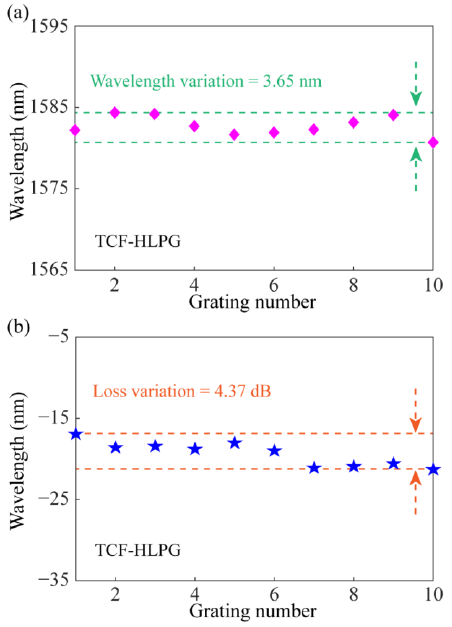
Figure 9. ( a ) The variation of resonance wavelength in the transmission spectra of different TCF- HLPG samples. ( b ) The variation of the transmission loss at the resonance wavelength in the spectra of different TCF-HLPG samples.